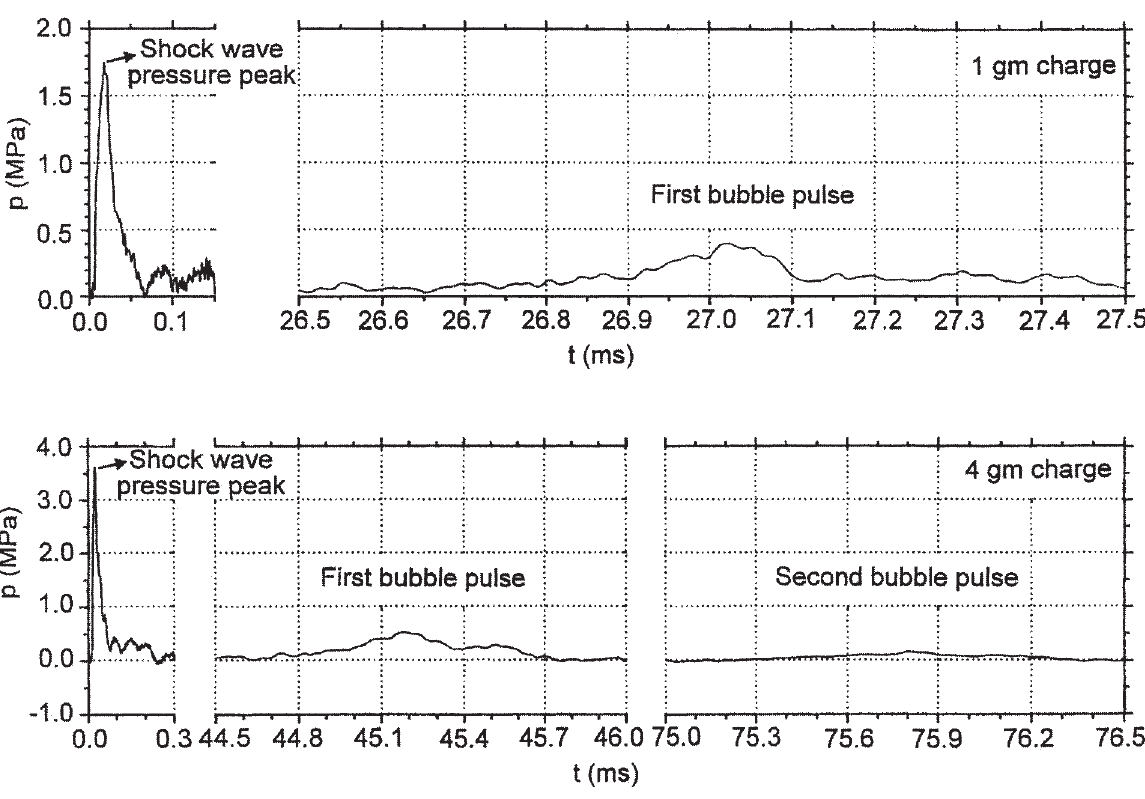
Fig. 4. Off side pressure–time history 1.535 m away from cylindrical charges of various mass (detonator type